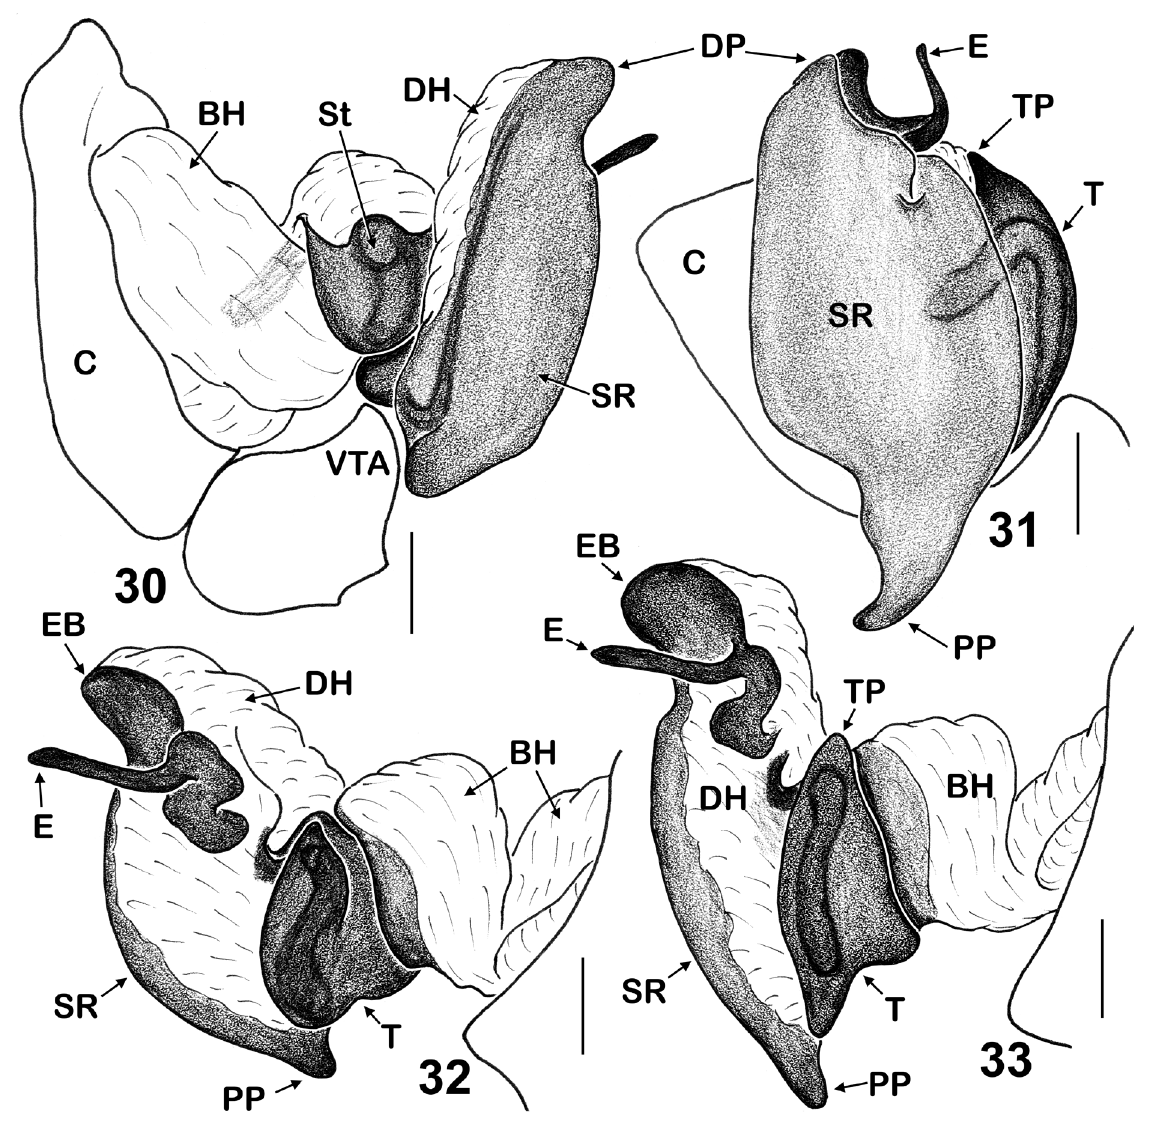
Figs 30–33. Expanded female palp of Stenaelurillus nigricaudus Simon, 1886 from Burkina Faso (Sissamba). 30 . Median view. 31 . Ventral view. 32 . Retrolateral-dorsal view. 33 . Retrolateral view. Abbreviations: see Material and methods. Scale bars: 0.1